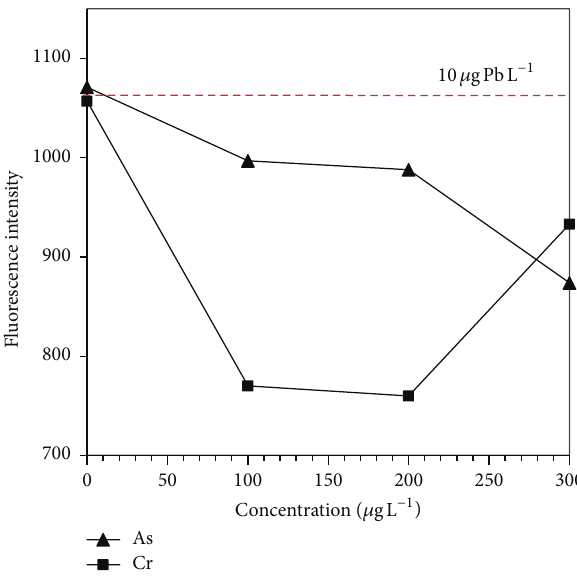
Figure 5: Effect of As and Cr concentrations on the fluorescence intensity of Pb. Peak height measurements for 10 𝜇 gPbL −1 .